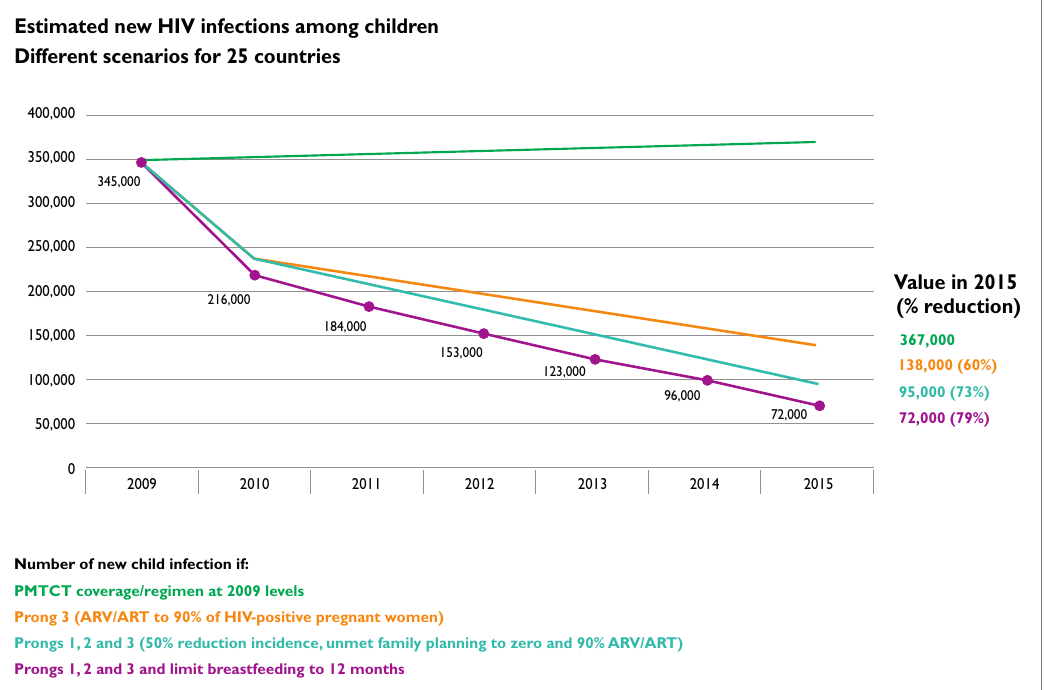
Source: Mahy et al. [5] and The Inter-Agency Task Team for Prevention and Treatment of HIV Infection in Pregnant Women Mothers and Their Children